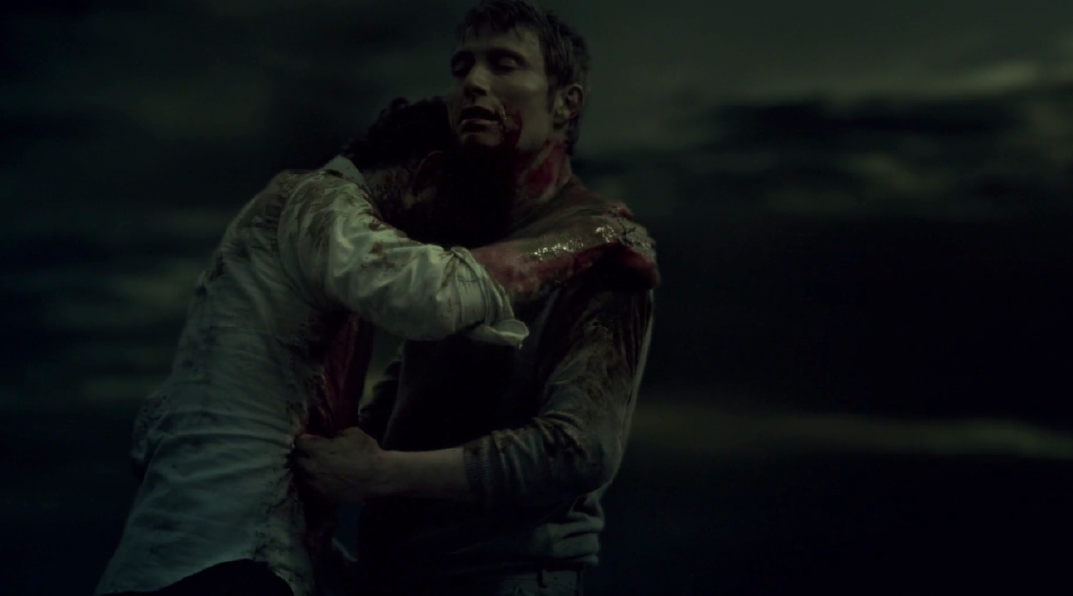
Figure 9. “See. This is all I ever wanted for you, Will. For both of us,” Hannibal assures Will. Screencap from the thirteenth (and final) episode of season 3, “The Wrath of the Lamb,” directed by Michael Rymer.